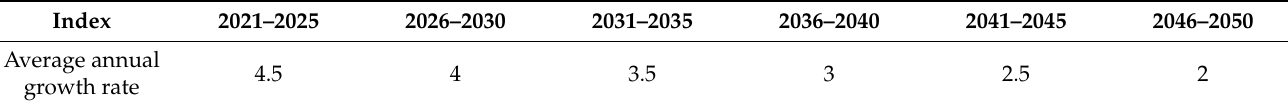
Table 1. The setting of economic growth rate in Beijing at various stages (unit: